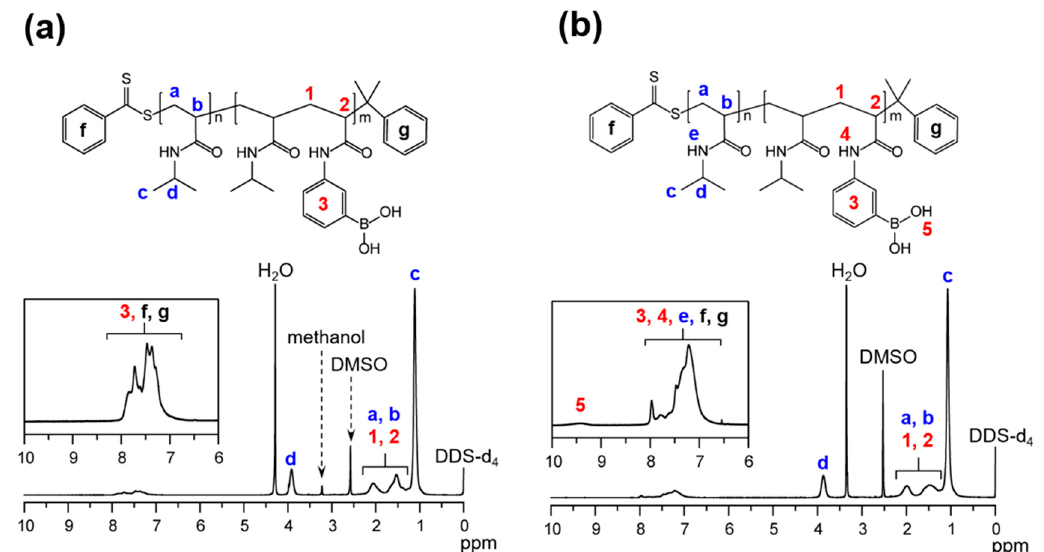
Figure 2. 1 H-nuclear magnetic resonance (NMR) spectra of ( a ) poly(NIPAAm- block -NIPAAm- co -PBA) in MeOD/DMSO-d 6 (=1:1) solvent and ( b ) poly(NIPAAm- block -NIPAAm- co -PBA) in DMSO-d 6 solvent at ambient temperature. DSS-d 6 (concentration; 5.00 × 10 − 4 M) was adopted as the internal reference.